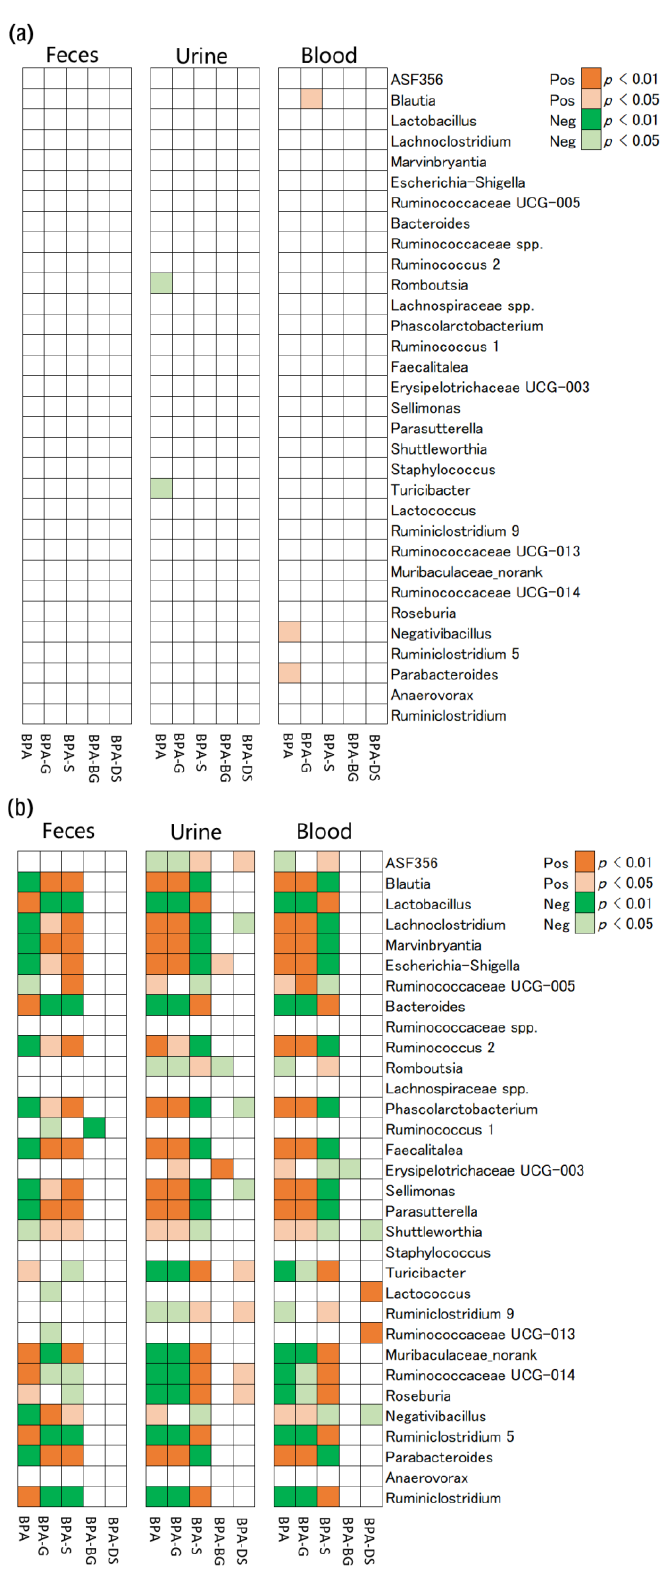
Figure 5. Correlations between the abundances of rat gut bacteria at the genus level and proportion of BPA and its metabolites in feces, urine, and blood of rats following ( a ) intervallic and ( b ) continuous BPA exposure. The red and green squares indicate a significantly positive and negative correlation, respectively.